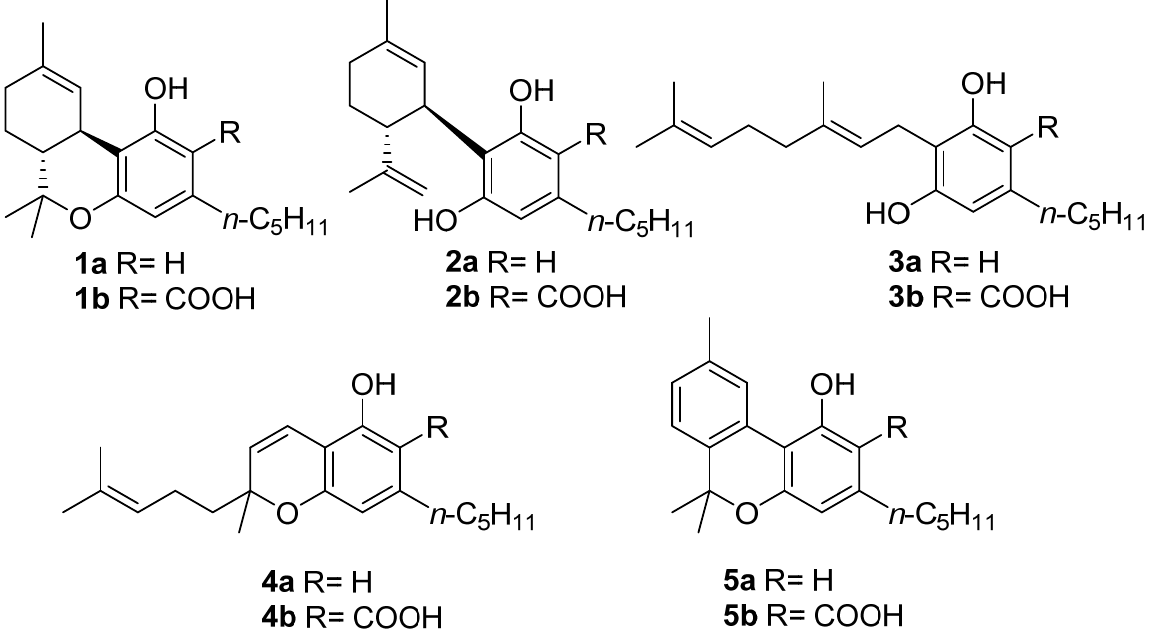
Figure 1. The structures of the “big four” phytocannabinoids [ ∆ 9 -THC ( 1a ), CBD ( 2a ), CBG ( 3a ) and CBC ( 4a )] and their acidic precursors ( 1b – 4b ), CBN ( 5a ) and its acidic form CBNA ( 5b ).